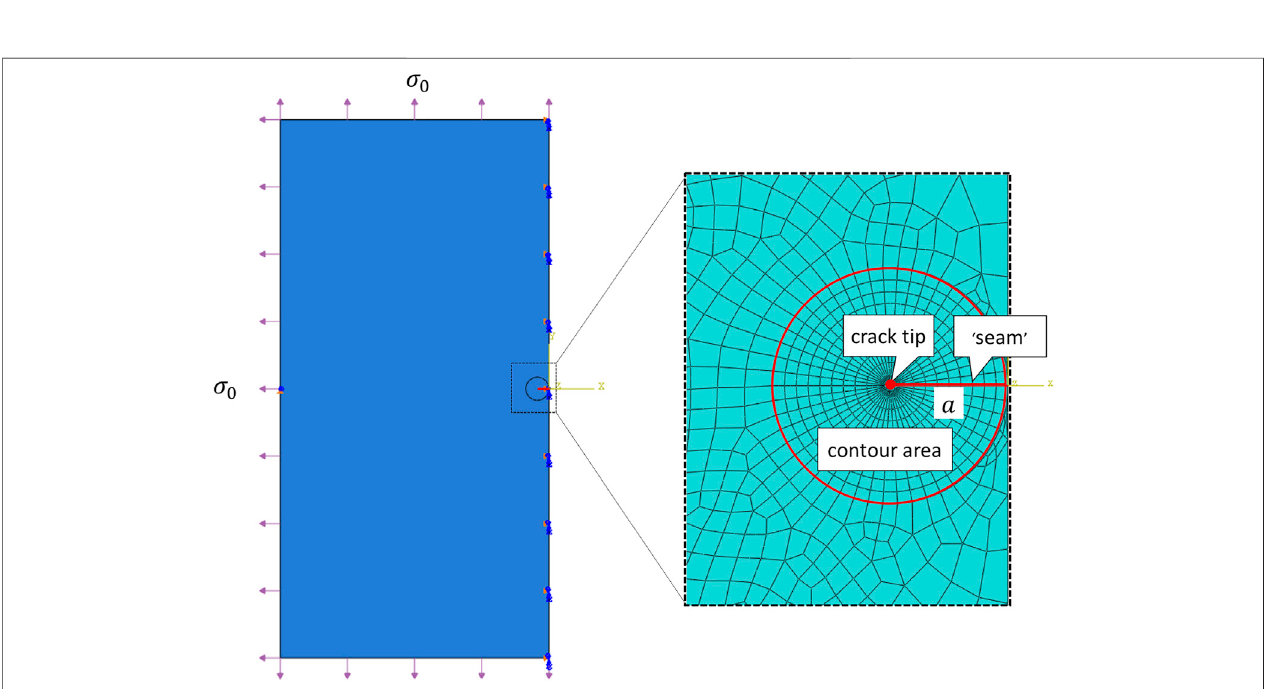
FIGURE2| Sketchofalarge 2D plate with atransverse tear oflength2 a under auniformlydistributed stress σ 0 at each edge.Note thatonly left halfoftheproblem was conducted in the FE simulation. The insert shows the designed FE mesh generation, where the crack tip was surrounded by a sweeping contour area for ERR